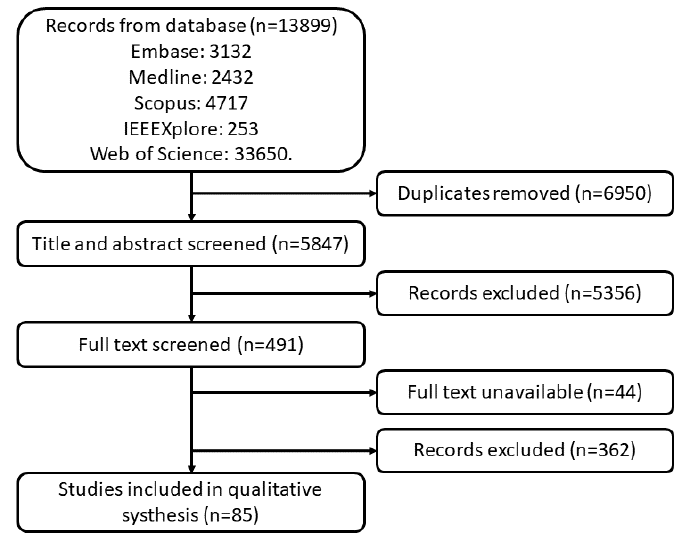
Figure 1. PRISMA flow diagram of search results. Forty-four full texts were not retrieved. Attempts to contact the authors were made, but no responses were